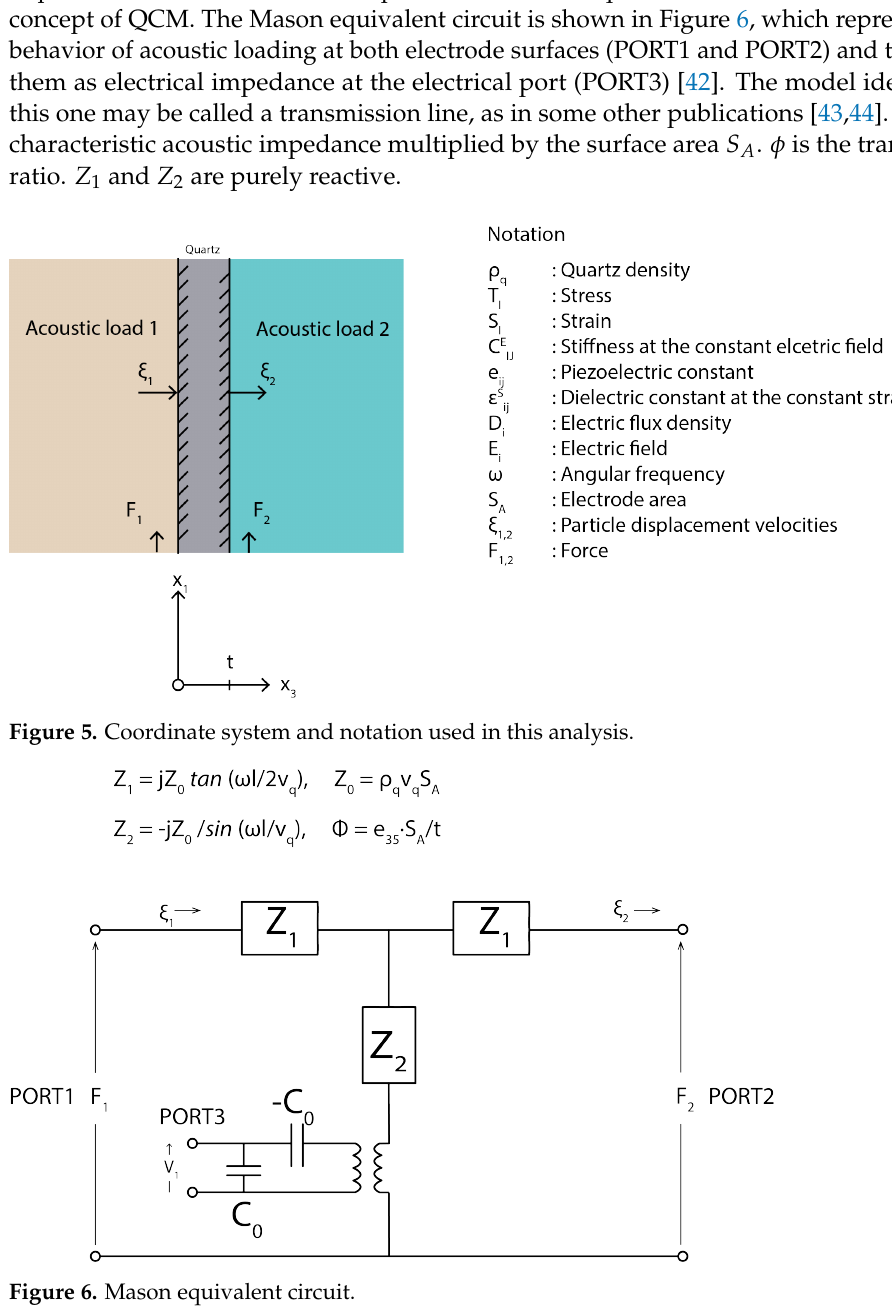
Figure 6. Mason equivalent